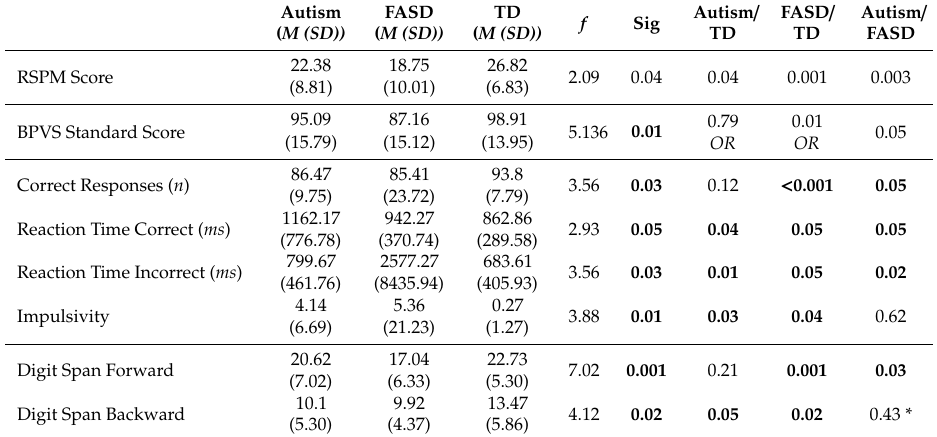
Table 4. Between-groups one-way ANOVA for RSPM, BPVS, CRT, and Digit